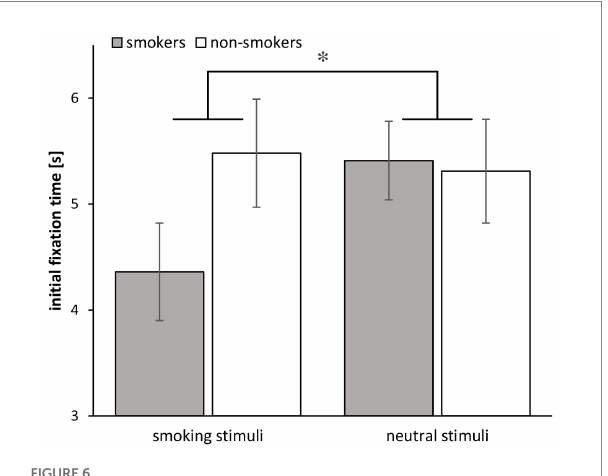
FIGURE 6 Initial fixation times for smokers ( n = 34) and non-smokers ( n = 37) in the free-viewing task. The asterisk indicates the significant interaction. Error bars show standard